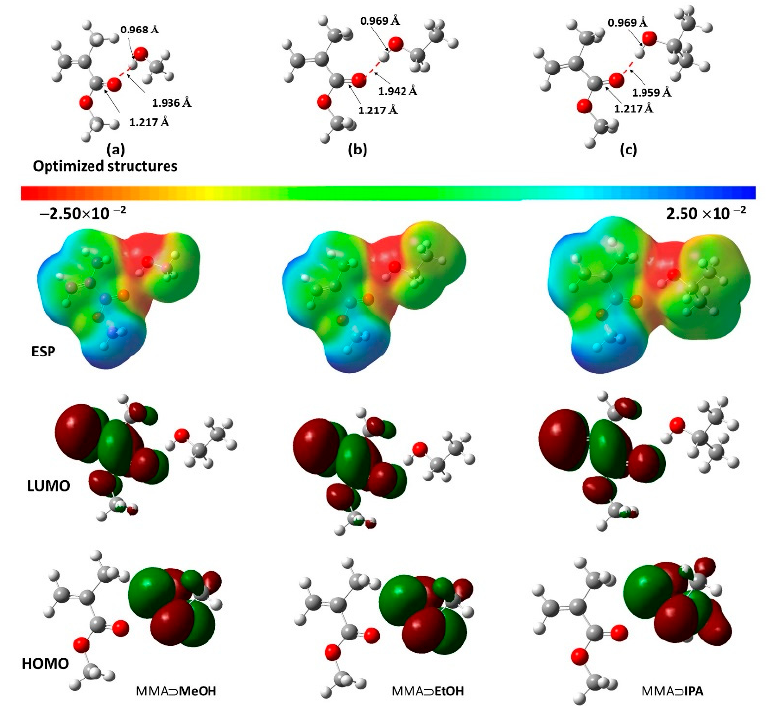
Figure 9. Optimized gas phase molecular structures, ESP, LUMOs, and HOMOs structures of MMA 1:1 complexes with alcohols: ( a ) MMA ⊃ MeOH; ( b ) MMA ⊃ EtOH; and ( c ) MMA ⊃ IPA at the B3LYP/6-311++G(d,p) level of theory.